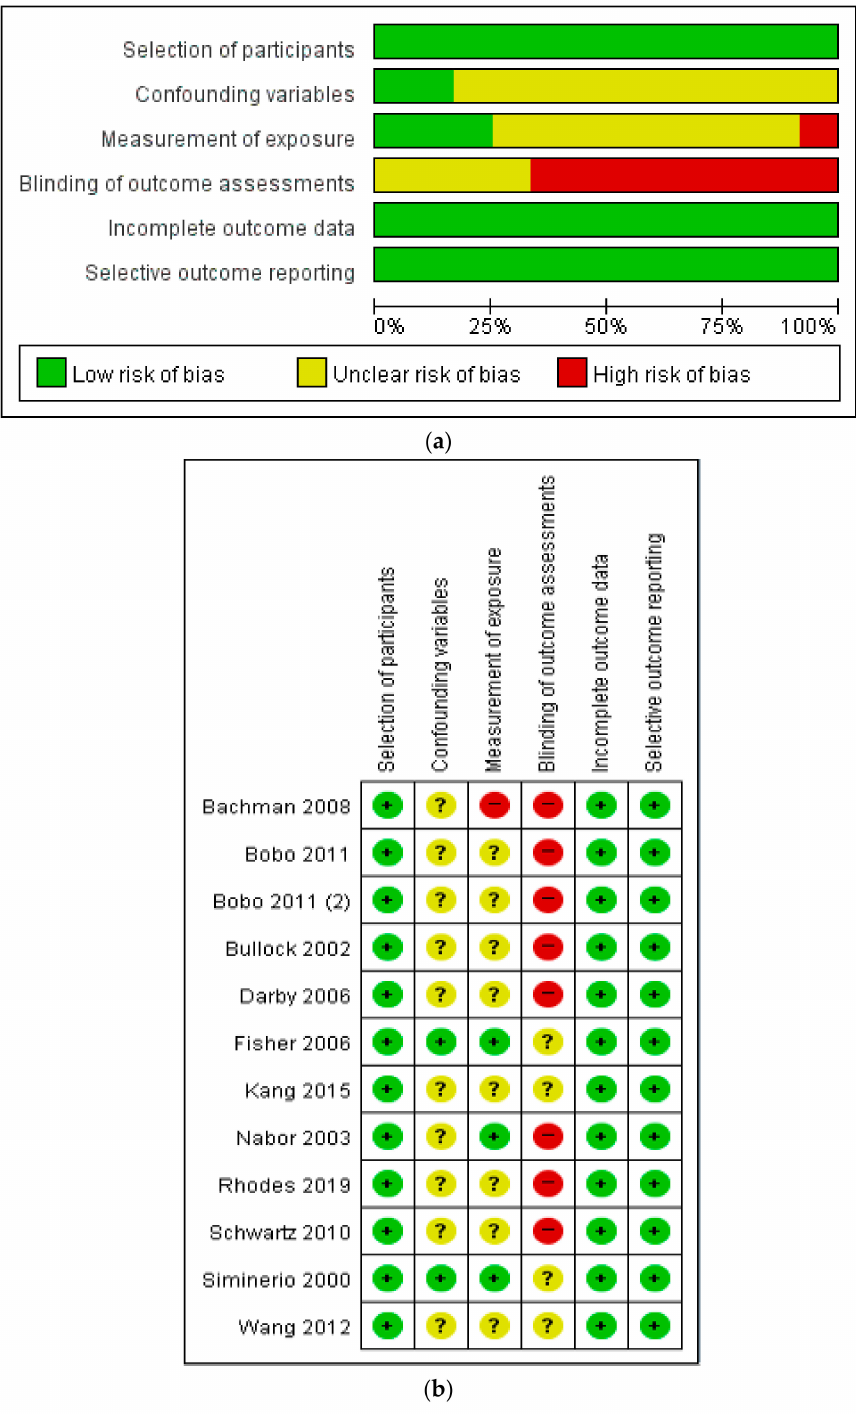
Figure 2. ( a ). Risk of bias graph [20]. ( b ). Risk of bias summary. Reviewing authors’ judgments about each risk of bias item presented as percentages across all included